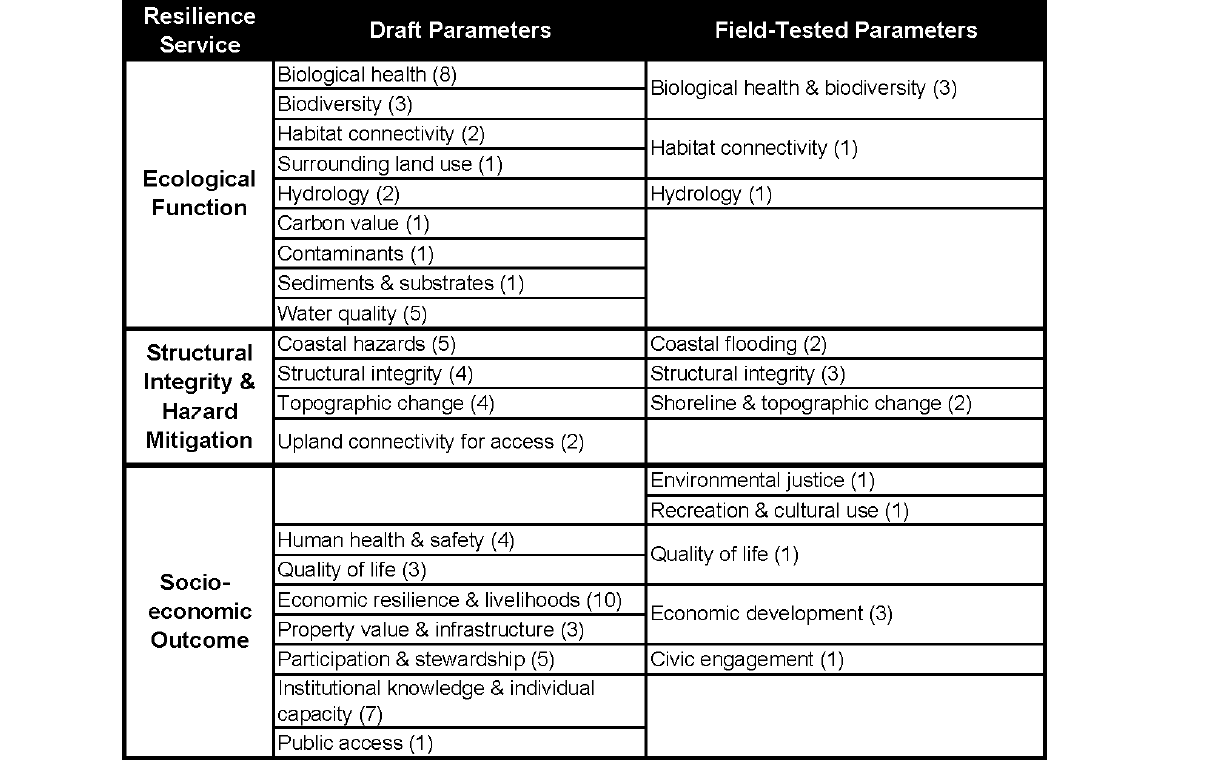
Fig. 6 . Comparison of draft parameters and field-tested